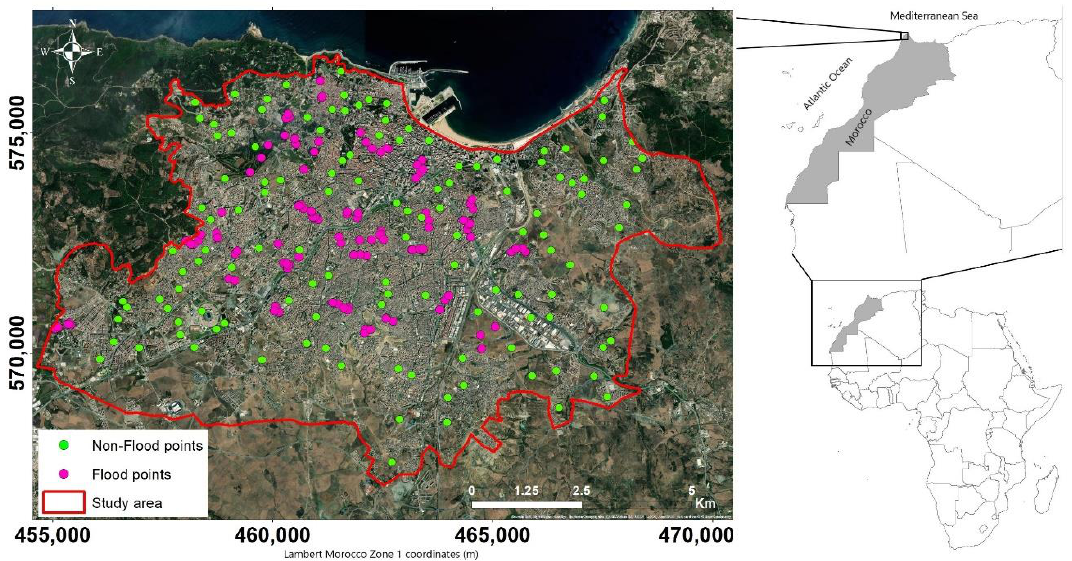
Figure 1. Location of the study area and distribution of flood and non-flood points.